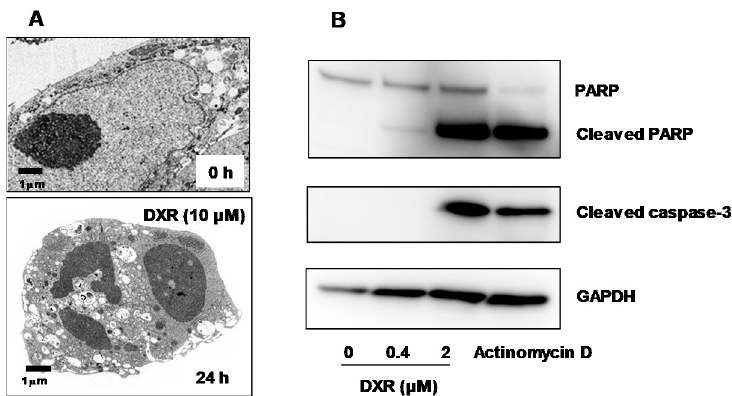
Figure 2. Doxorubicin induced apoptosis in human oral keratinocyte, demonstrated by transmission electron ( A ) and western blot analysis ( B ). Cited from Reference [27] with permission.